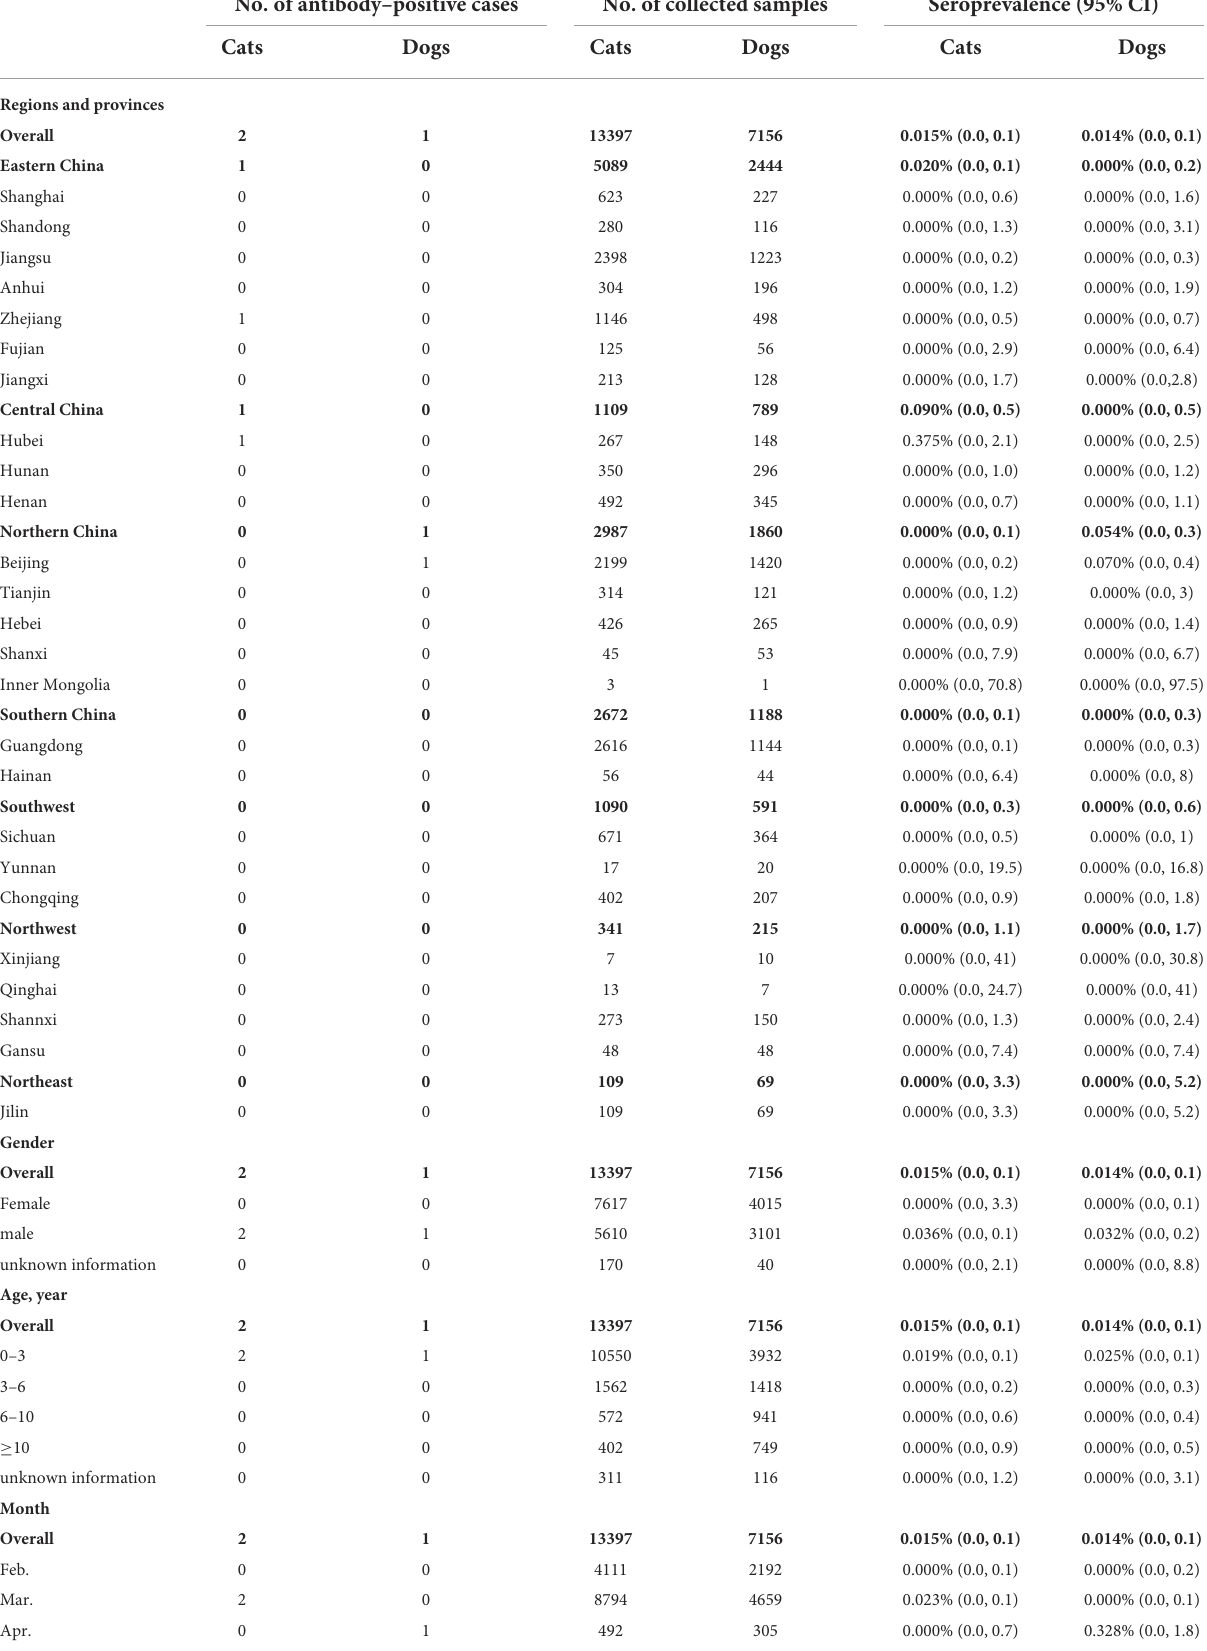
TABLE 1 Animal sera and SARS-CoV-2 seroprevalence